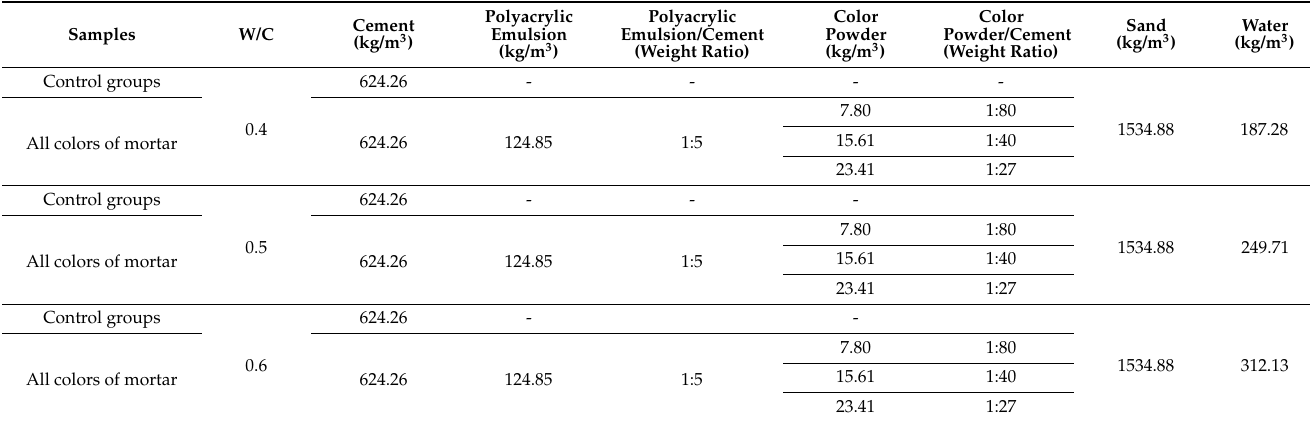
shown in Table 3, below. Table 3. Mix ratios of colored mortar at W/C = 0.4, 0.5 and